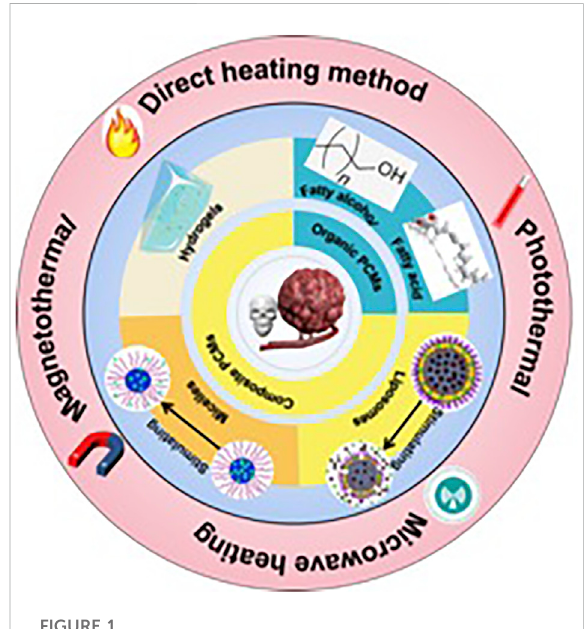
FIGURE 1 Types of PCMs used for intelligent antitumor administration in nanomedicine and the mechanism of PCMs controlled release in tumor